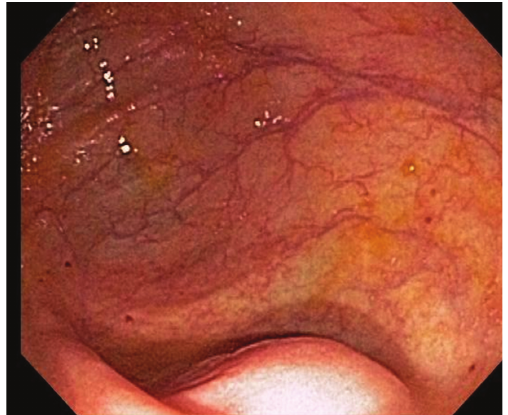
Figure 1: Protuberance at the appendiceal orifice seen at colono- scopy in Case 1.